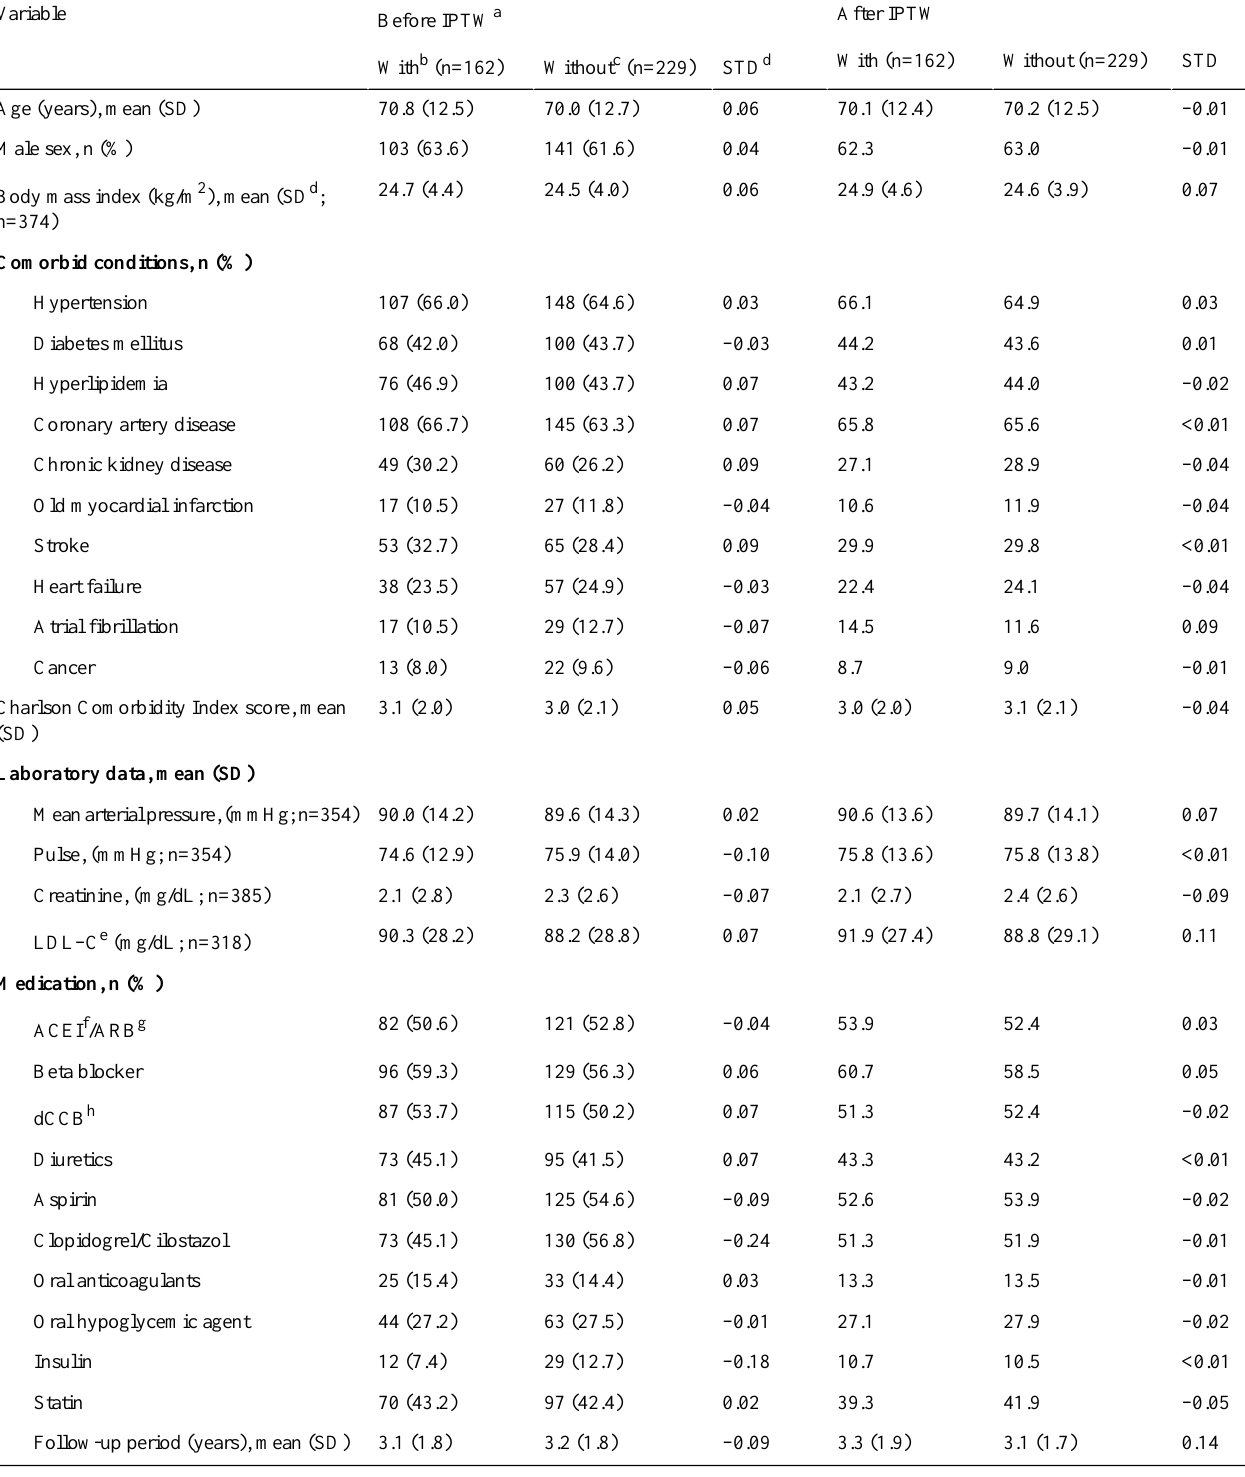
Table 1. Baseline characteristics of the study patients with peripheral arterial occlusive disease who participated (n=162) and did not participate (n=229) in the telemedicine